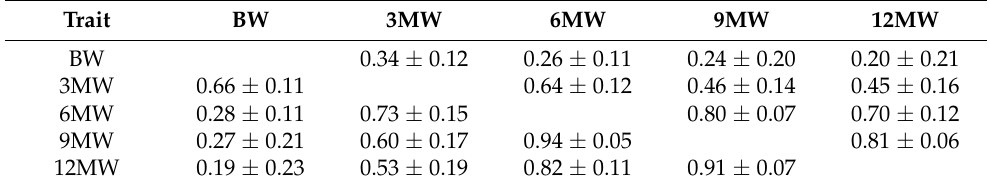
Table 4. Genetic and phenotypic correlations among body-weight traits in Mecheri